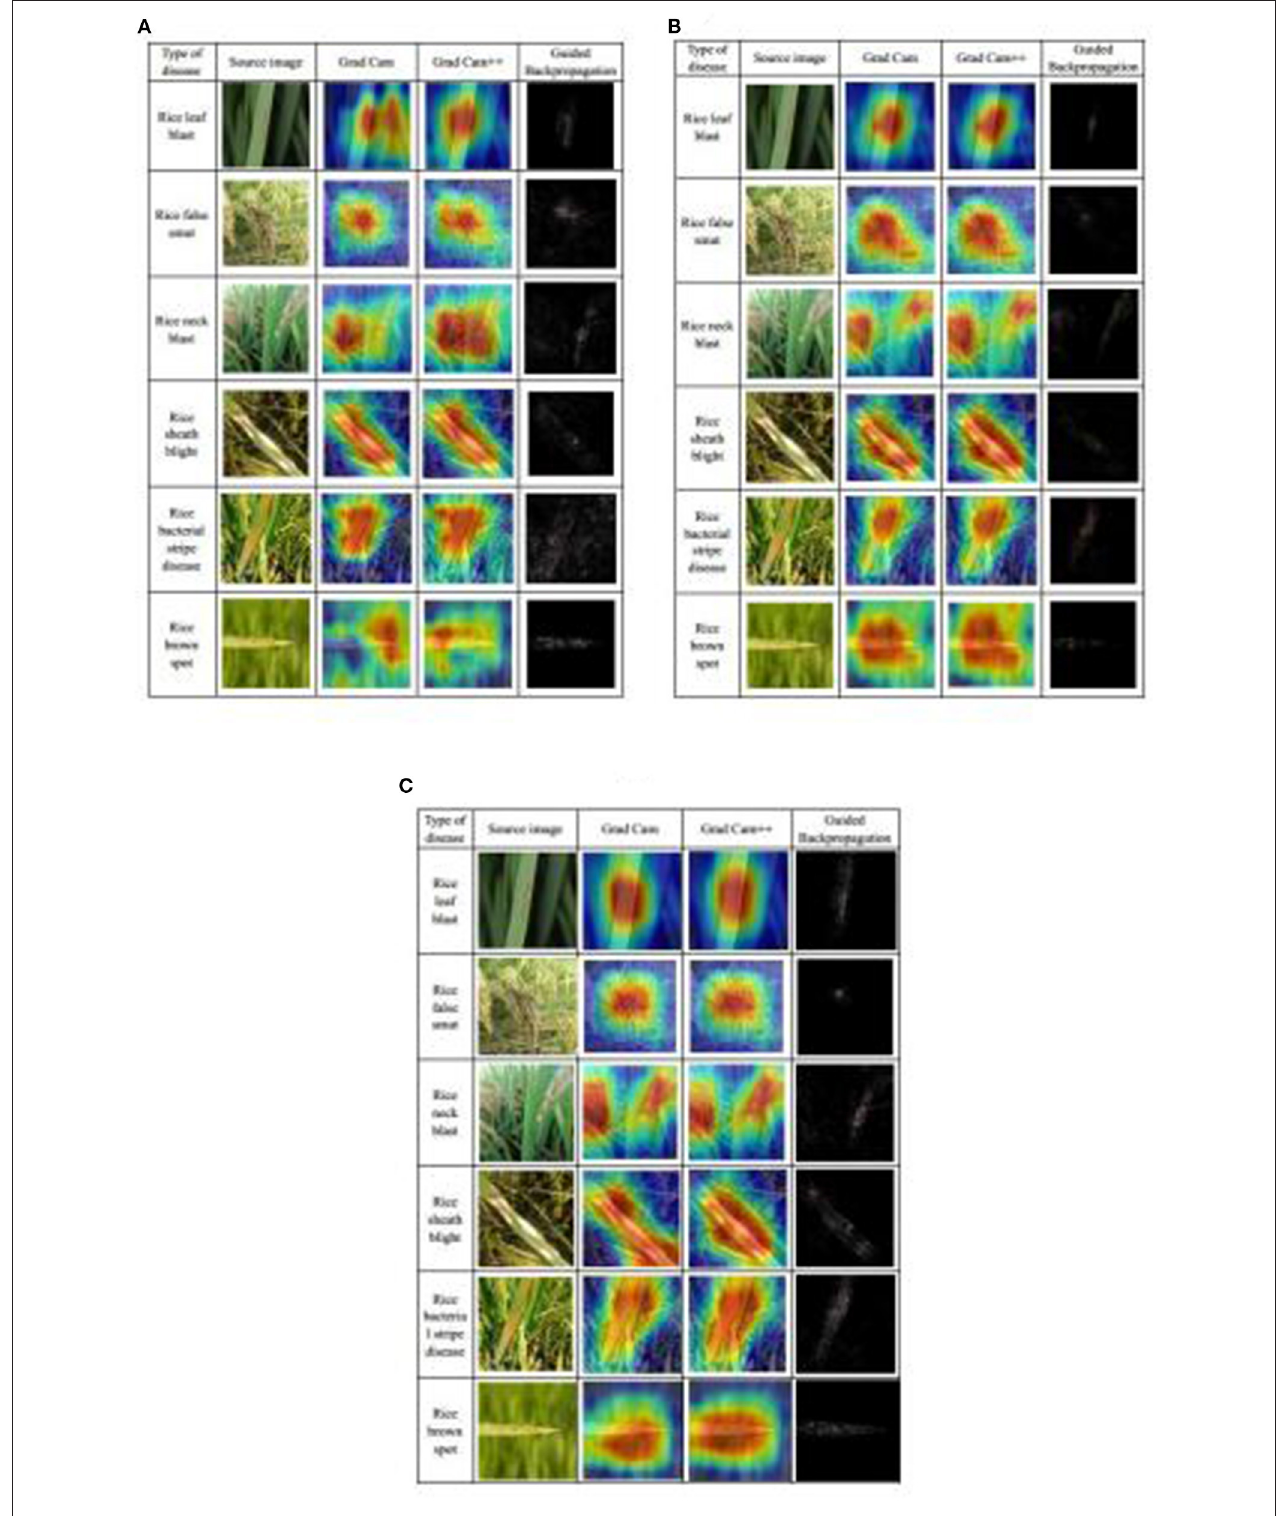
FIGURE 8 | Visualization of rice disease diagnosis results from the three best submodels: (A) DenseNet-121, (B) ResNeSt-50, and (C) SE-ResNet-50.